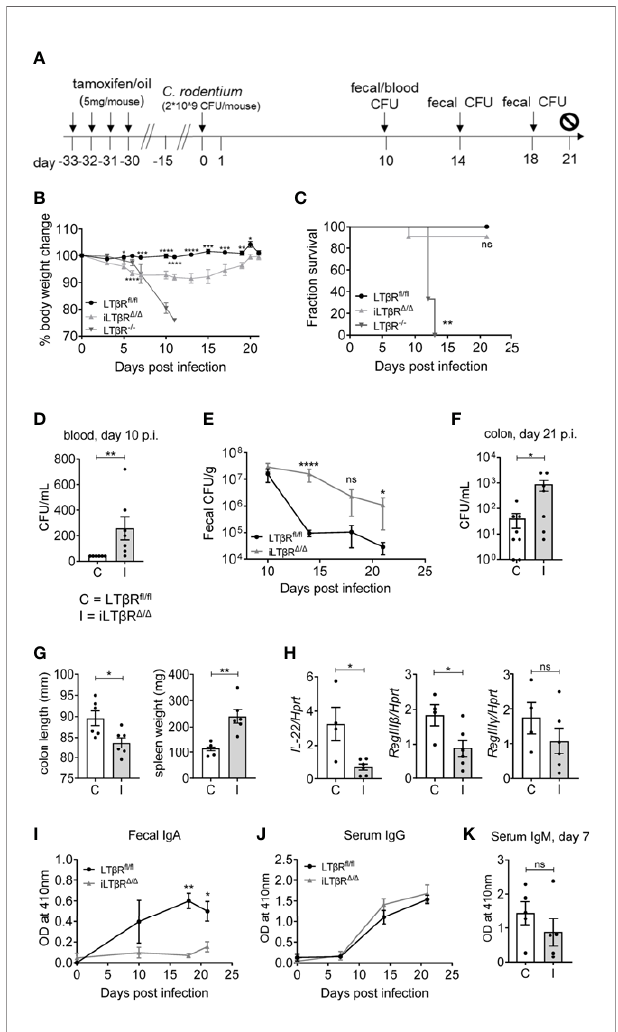
FIGURE 6 | LT b R signaling contributes to protection against C. rodentium and is required for the generation of C. rodentium -speci fi c IgA responses. (A) Scheme for C. rodentium infection and TAM treatment. (B) Percentage body weight change over the course of infection. (C) Analysis of survival. Signi fi cance was determined using the Log-rank (Mantel-Cox) and Gehan- Breslow-Wilcoxon tests. (D – F) Bacterial titers in blood (D) , feces (E) and colons (F) at the indicated timepoints. (G) Colon length and spleen weight at 21d post infection. (H) Expression of IL-22, RegIII b and RegIII g in the colon determined by qPCR at 6d post infection. (I, J) Analysis of C. rodentium - speci fi c fecal IgA (I) , serum IgG (J) , and serum IgM (K) levels by ELISA. Results shown are representative fi gures from three independent experiments (n=3-11 mice per group). Signi fi cance for panels B, E, I, and J were determined by two-way ANOVA followed by Mann-Whitney tests. For panels D, F, G, H and K signi fi cance was determined using Mann-Whitney tests. Data shown are means ± SEM. Bars show the mean, symbols represent individual mice. Not signi fi cant (ns, p > 0.05), *p < 0.05, **p < 0.01, ***p < 0.001, ****p < whether CD169 + SCS macrophages were replaced with CD169 +/ lo SIGNR1 + medullary sinus macrophages or converted their phenotype in iLT b R D / D mice. LT provided by B cells was shown to be responsible for the maintenance of SCS